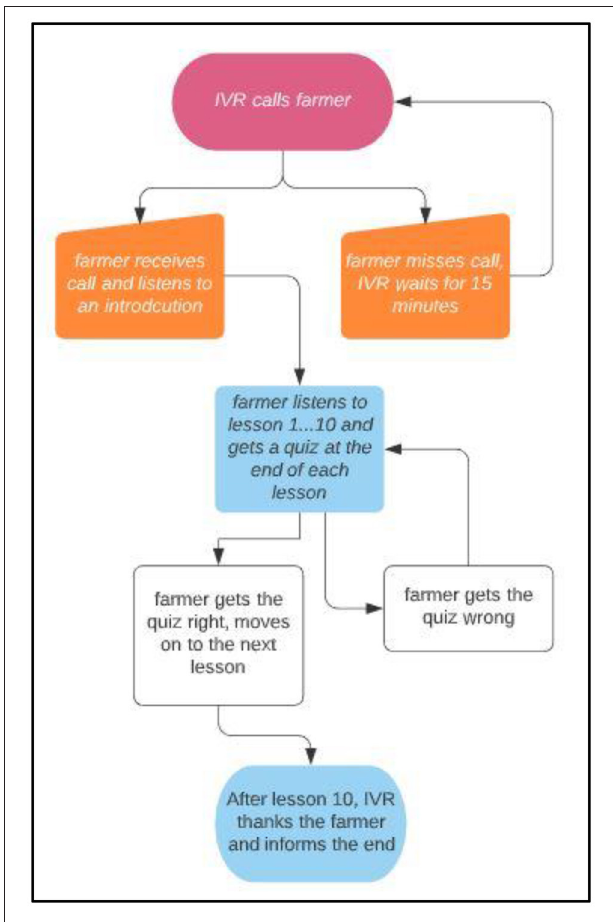
FIGURE 1 | IVR processing